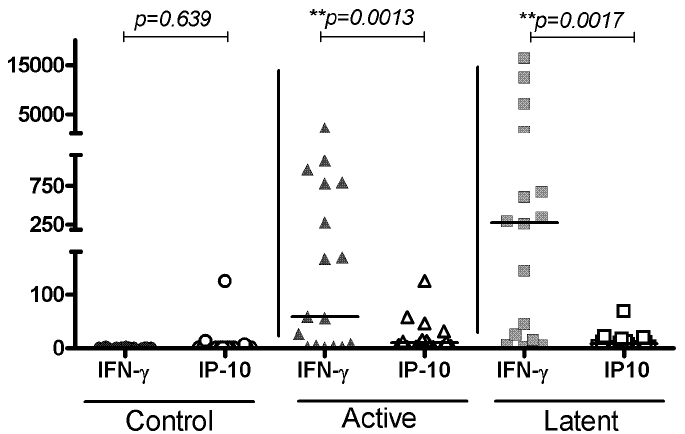
Figure 3. Stimulation index of IP-10 and IFN- c in active TB, LTBI and a control group. Horizontal lines indicate medians. Controls are represented by # , active TB by n , and LTBI by % . Open symbols represent IP-10, closed symbols represent IFN c